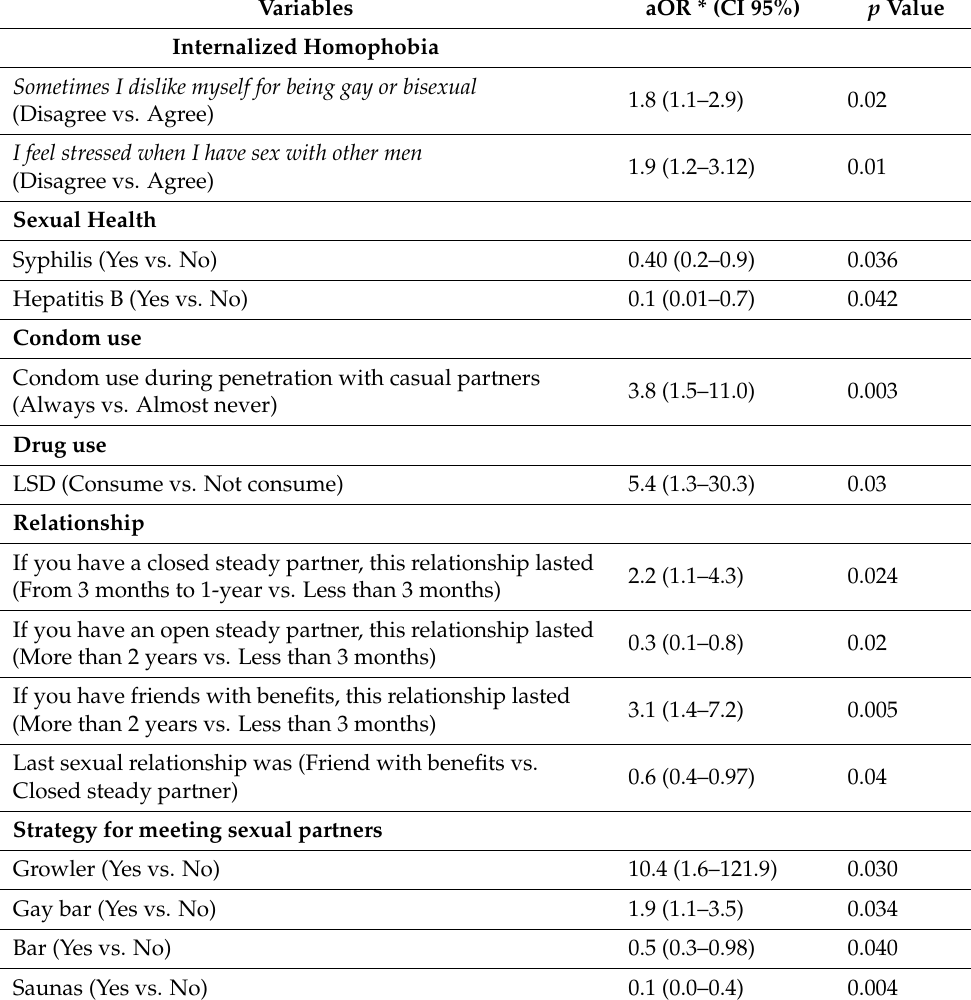
Table 4. Multivariate logistic regression of factors significantly associated with HIV risk